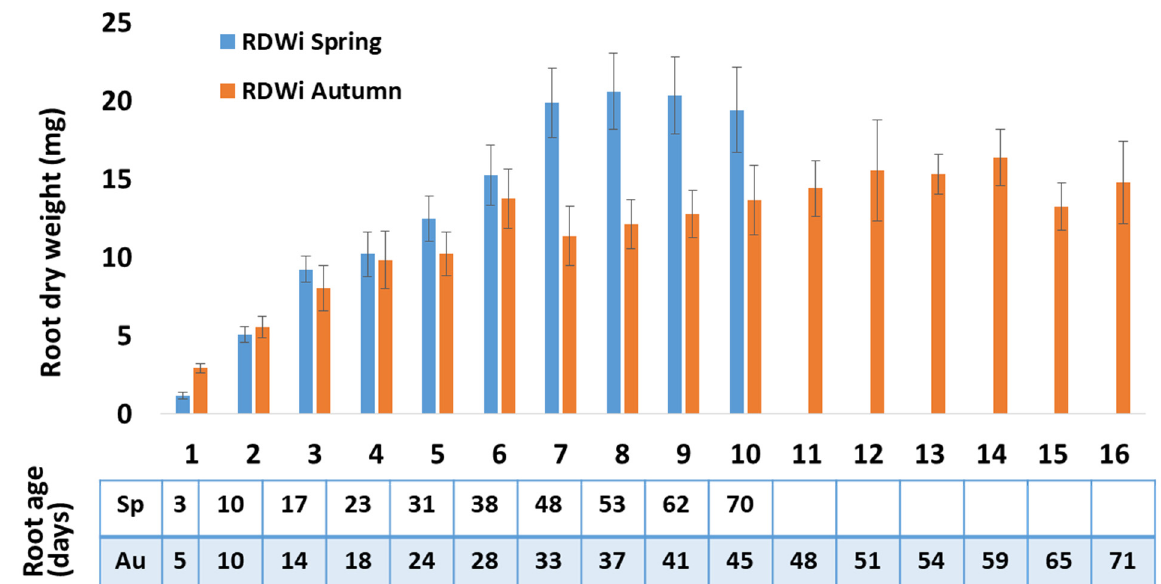
Figure 2. Individual root dry weight (RDWi) observed for Aberdart perennial ryegrass at successive root bearing phytomers in Spring and Autumn experiments. The number of roots per phytomer (Rp) is provided in Table S2. The panel below shows root age in spring (Sp) and autumn (Au) in days. Data are means for 30 and 16 plants in spring and autumn, respectively, whose roots were dissected by phytomer position. Vertical bars indicate the standard error of the mean value.